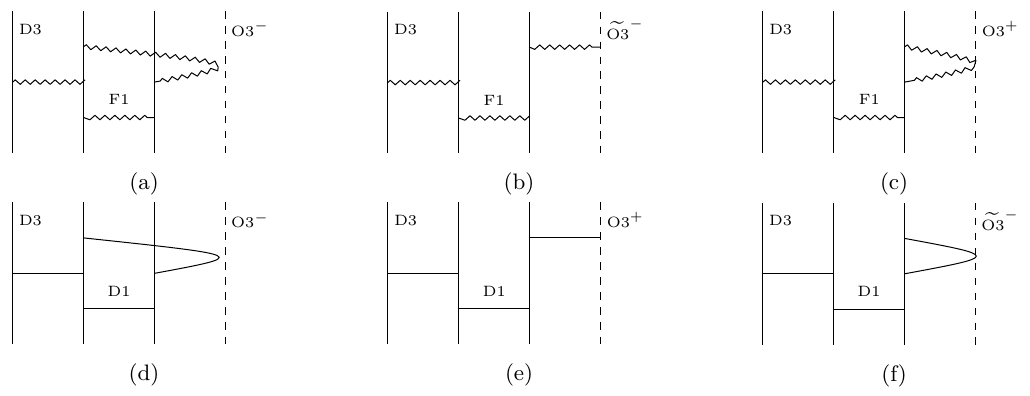
Figure 1. F1 and D1 pattern on a stack of D3s on top of O3